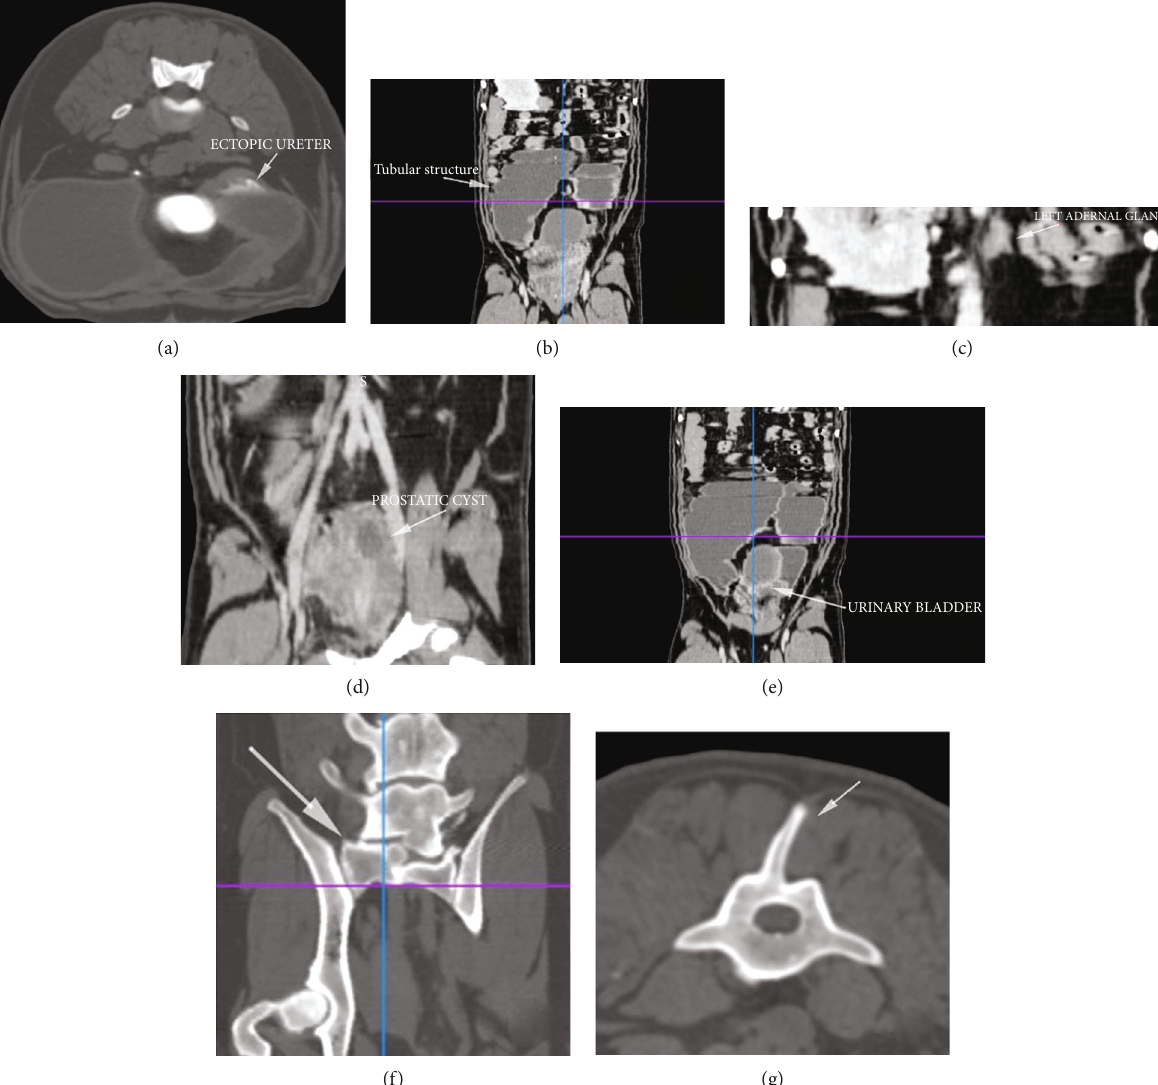
Figure 3: Abdominal computed tomography (CT): (a) transverse scan showing the ectopic megalic ureter; (b) multiplanar reformat (MPR) reconstruction showing the tubular structure; (c) MPR reconstruction showing the left adrenal gland; (d) MPR reconstruction showing the hypertrophic prostate with a prostatic cyst; (e) MPR reconstruction showing the urinary bladder surrounded by the convolute saccular structure; (f) MPR reconstruction showing the lumbosacral transitional vertebra; (g) transverse scan showing the 4 th lumbar vertebra with left lateral deviation of the dorsal spinal